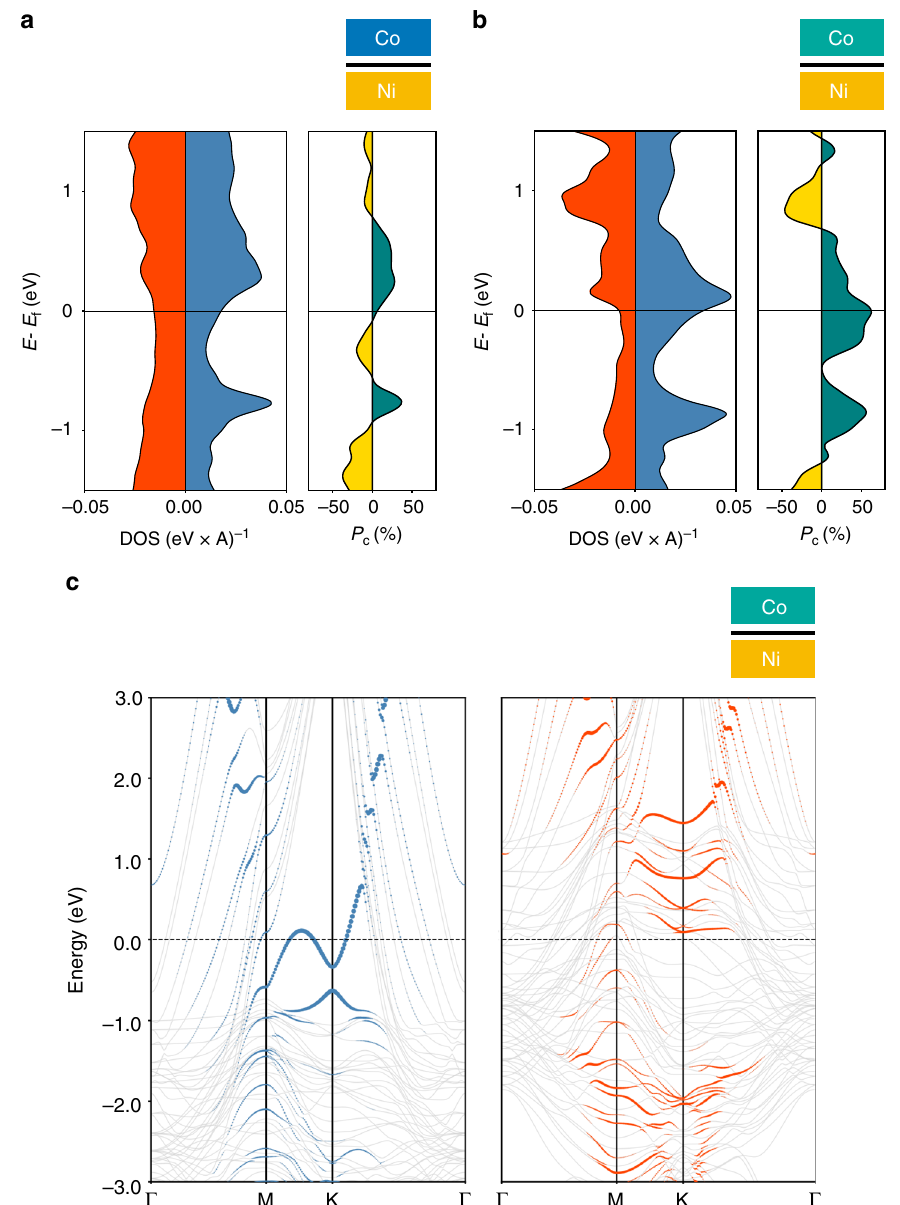
Fig. 7 Spin-dependent band calculations for complete spin valve stacks. Strikingly, when a both Ni and Co are in contact with graphene, the spin polarization of graphene can be reversed and becomes positive. The amplitude of the spin polarization seems to depend on the extent of FM/Gr hybridization, with a strong increase b in the case of strong interaction with Co. This reveals that the spin polarization of graphene in Ni/Gr/Co cannot be simply derived from the spin polarization of graphene in Ni/Gr and Co/Gr. c Electronic band structure of Ni/Gr/Co junction for (blue) majority and (red) minority electronic bands are displayed. Blue and red dots correspond to the projection of the majority and minority Hamiltonian eigenstates on carbon atoms. The size of the dot is proportional to the amplitude of the projection, i.e. the “ carbon ” character of the eigenstate. For majority carriers, the Dirac cone structure is shifted and a gap is opened. In contrast, for minority carriers, the Dirac cone structure has completely vanished due to hybridization. A strong spin asymmetry has been induced by proximity